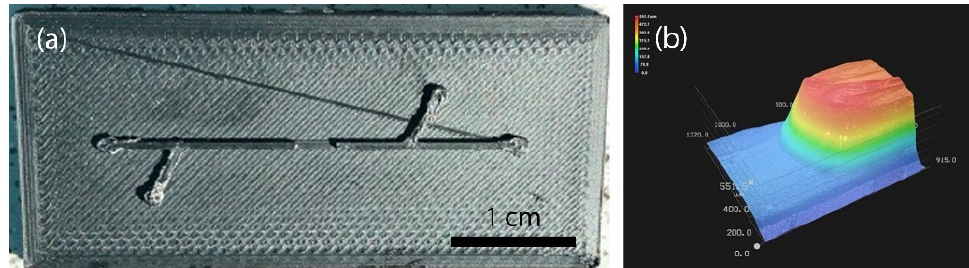
Figure 8. Casting mold fabricated out of ABS with the Ultimaker S5. ( a ) Casting mold. ( b ) 3D picture of the sieve taken from the casting mold at the transition of the lower to the higher channel structure.